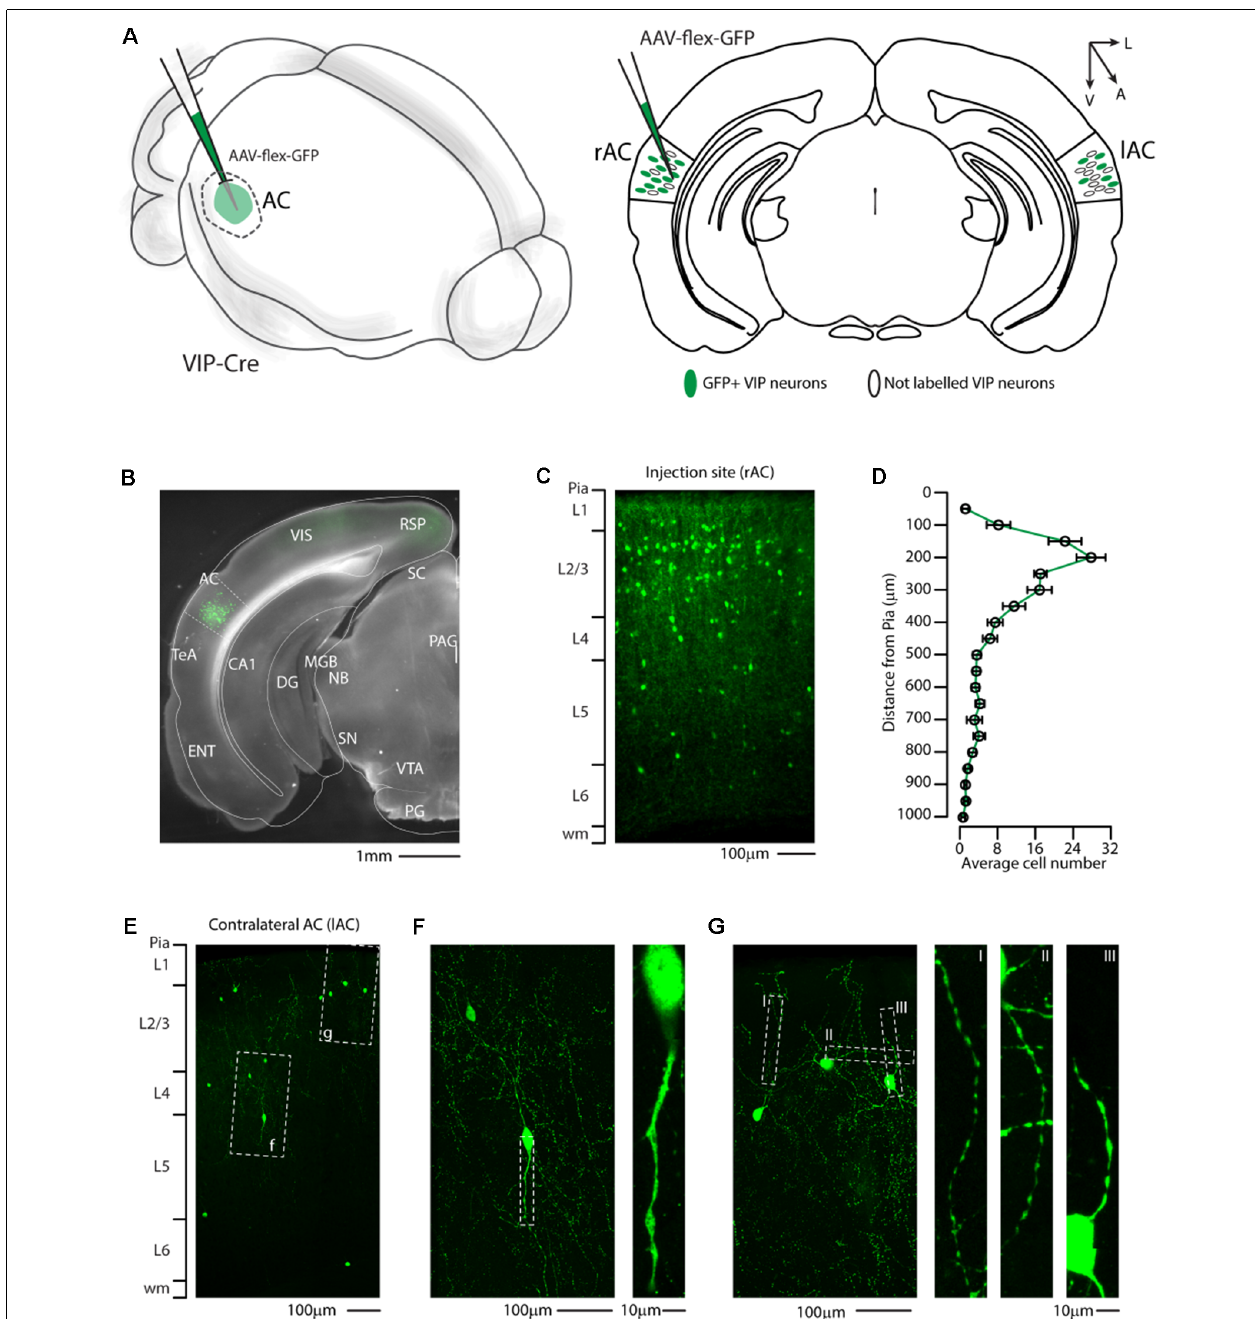
FIGURE 1 | Distribution of VIP-expressing neurons in the auditory cortex. (A) Schematic representation of right auditory cortex viral injection of AAV-flex-GFP. VIP-expressing neurons in both the injected (right AC, rAC) and contralateral (left, lAC) auditory cortex express GFP in a Cre-dependent manner. (B) Representative coronal section of an acute slice of the injection site (200 µ m thick), with bright field (gray) and GFP expressing neurons (green). The Allen brain atlas coronal table superimposed for reference indicates the correct targeting of the auditory cortex. Scale bar: 1 mm. (C) High magnification confocal image of the injection site showing GFP expressing neurons in the right auditory cortex. Scale bars: 100 µ m. (D) Laminar distribution of VIP neurons in the auditory cortex, quantified every 50 µ m from Pia (0) to white matter (1 mm). Data are expressed ad mean ± s.e.m. (E) Representative high magnification confocal image of the contralateral Auditory cortex showing retrograde labeled GFP expressing neurons. Scale bars: 100 µ m. (F,G) Details of dashed square (f and g) of (E) , with corresponding high magnification of the dendritic arborization of GFP+ VIP-expressing neurons showing their characteristic thin and aspiny morphology. Scale bars: 100 µ m and 10 µ m. RSP, retrosplenial cortex; VIS, visual cortex; TeA, temporal association cortex; AC, auditory cortex; ENT, enthorinal cortex; CA1, Cornu Ammonis of the hippocampus subfield 1; DG, dentate gyrus; SC, superior colliculus; MGB, medial geniculate body; NB, nucleus of the brachium of the inferior colliculus; PAG, periacqueductal gray; SN, substantia nigra; VTA, ventrotegmental area; PG, pontine gray.